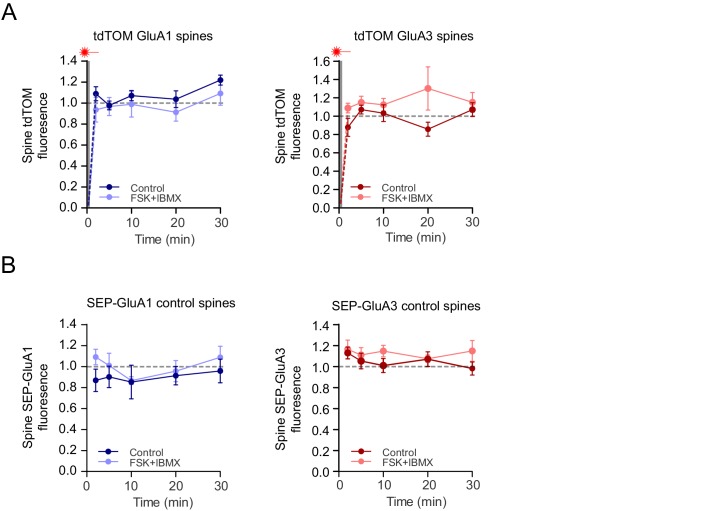
Controls in FRAP experiment.(A) Fast fluorescence recovery of cytoplasmic TdTomato signal in photobleached spines. Left: tdTomato signal of spines transfected with SEP-GluA1 + tdTomato in the absence (dark blue; n=8) and the presence (light blue; n=6) of forskolin and IBMX (RM-ANOVA, p=0.09). Right: tdTomato signal of spines transfected with SEP-GluA3 + tdTomato in the absence (dark red; n=7) and the presence (light red; n=7) of forskolin and IBMX (RM-ANOVA, p=0.3). (B) SEP signal in neighboring control spines were unaffected after photobleaching. SEP signals normalized to tdTomato signal of control non-bleached spines transfected with SEP-GluA1 (left: n=6; RM-ANOVA, p=0.3) or SEP-GluA3 (right: n=5; RM-ANOVA, p=0.06) in the absence (dark) and the presence (light) of forskolin and IBMX. Error bars indicate SEM.